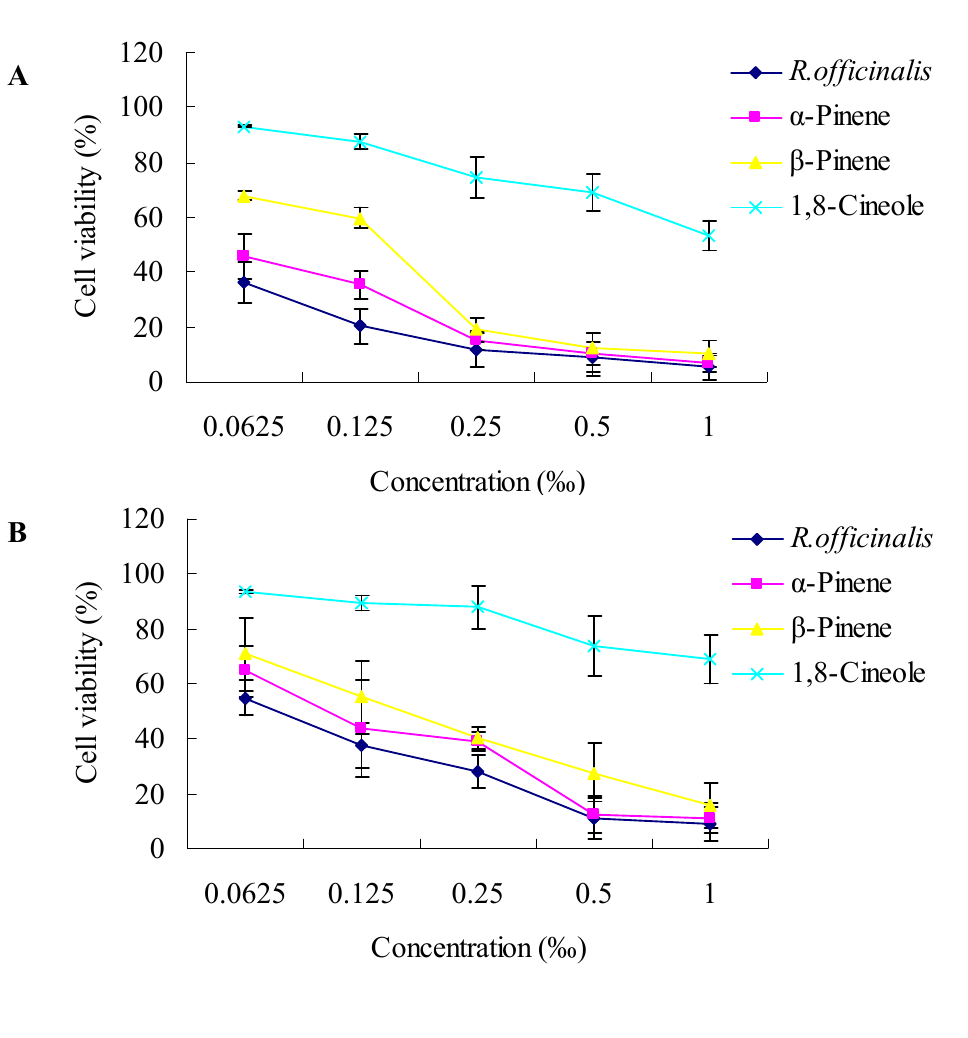
Figure 2. Dose-dependent cytotoxicity of R. officinalis L. essential oil and three of its main components (1,8-cineole, α -pinene and β -pinene; 48 h exposure) towards SK-OV-3 ( A ), HO-8910 ( B ) and Bel-7402 ( C ) cell lines as determined by the MTT assay. Values are expressed as means ± SD of three independent experiments. Standard deviations were less than